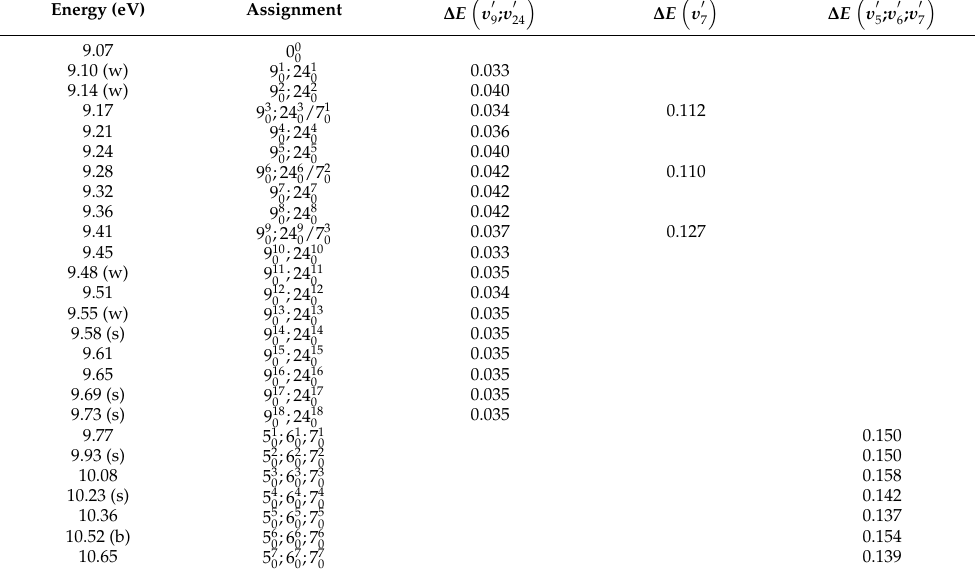
Table 8. Proposed vibrational assignments in the 9.0 − 10.8 eV absorption band of 2BrPyr (Band VI). ∆ E (in eV) represents the energy of one extra quanta in the vibrational progression. The symbol “/” means both modes are involved; the symbol “;” means two alternative